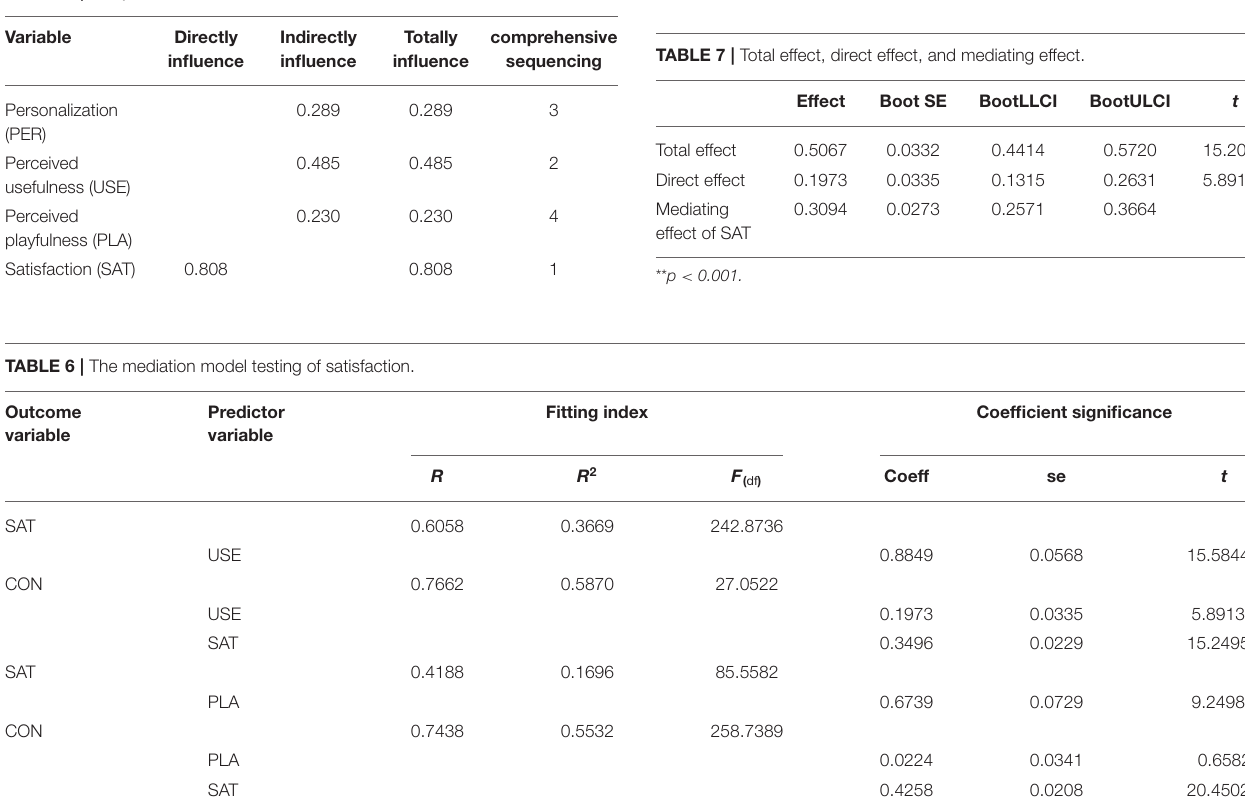
TABLE 5 | Analysis on the effect of each variable.